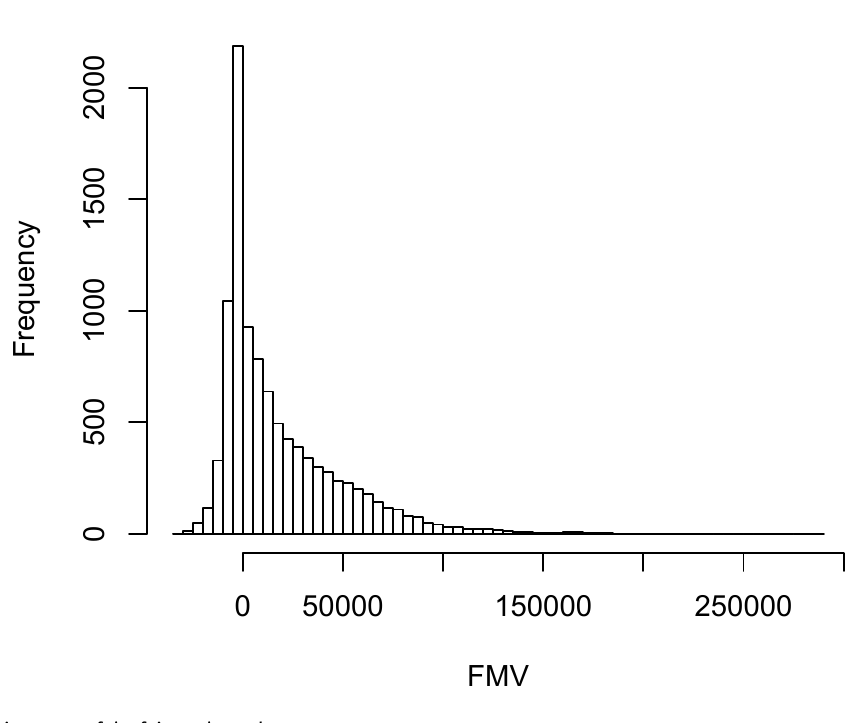
Figure 2: A histogram of the fair market